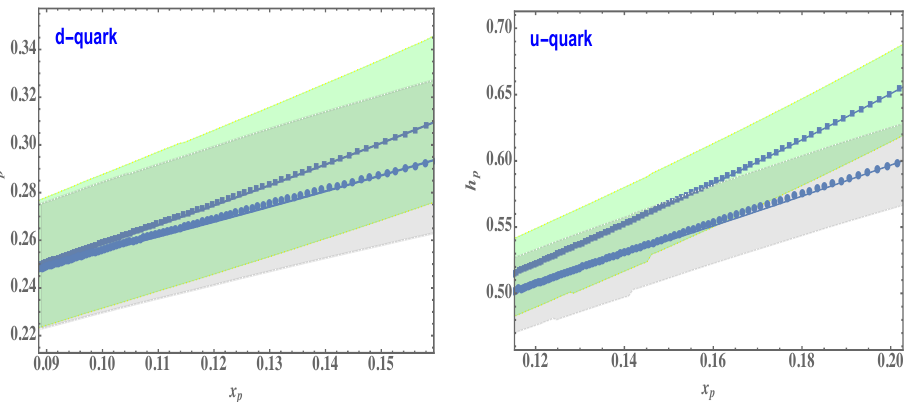
Figure 6. The peak position-height correlation for the PDF sets of CTEQ6 parameterization [20] for valence d-quark ( left panel ) and u-quark ( right panel ) distributions. Solid squares indicate NLO parameterization based on the MS scheme and solid circles, NLO based on the DIS scheme [19]. The curves are results of the fits according to Equation (10). The shaded regions show the uncertainties evaluated by using error sets in Hessian representation